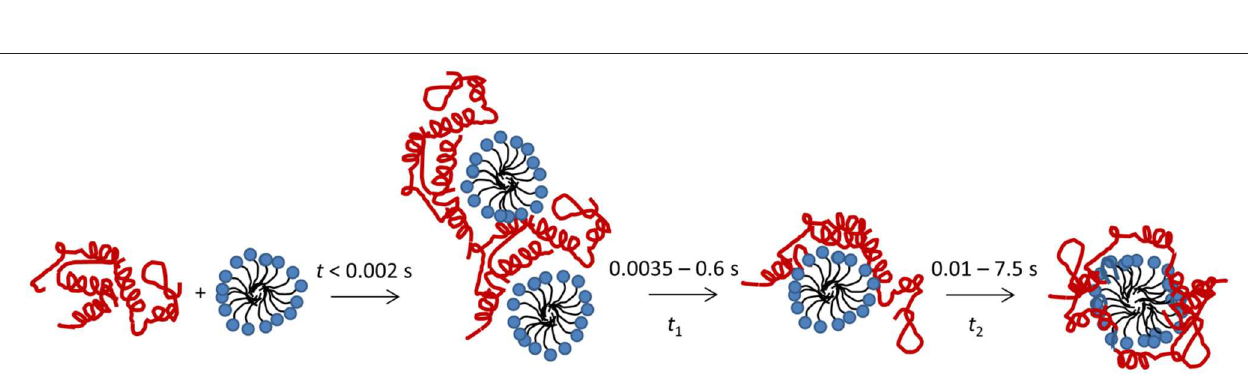
Frontiers in Molecular Biosciences | www.frontiersin.org